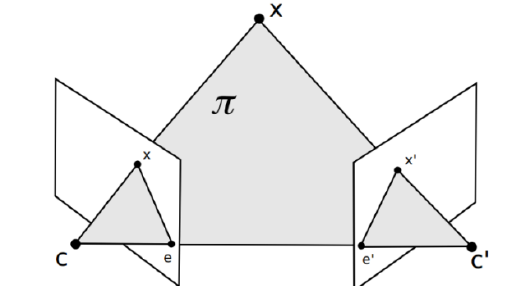
Figure 7. Simple representation of epipolar